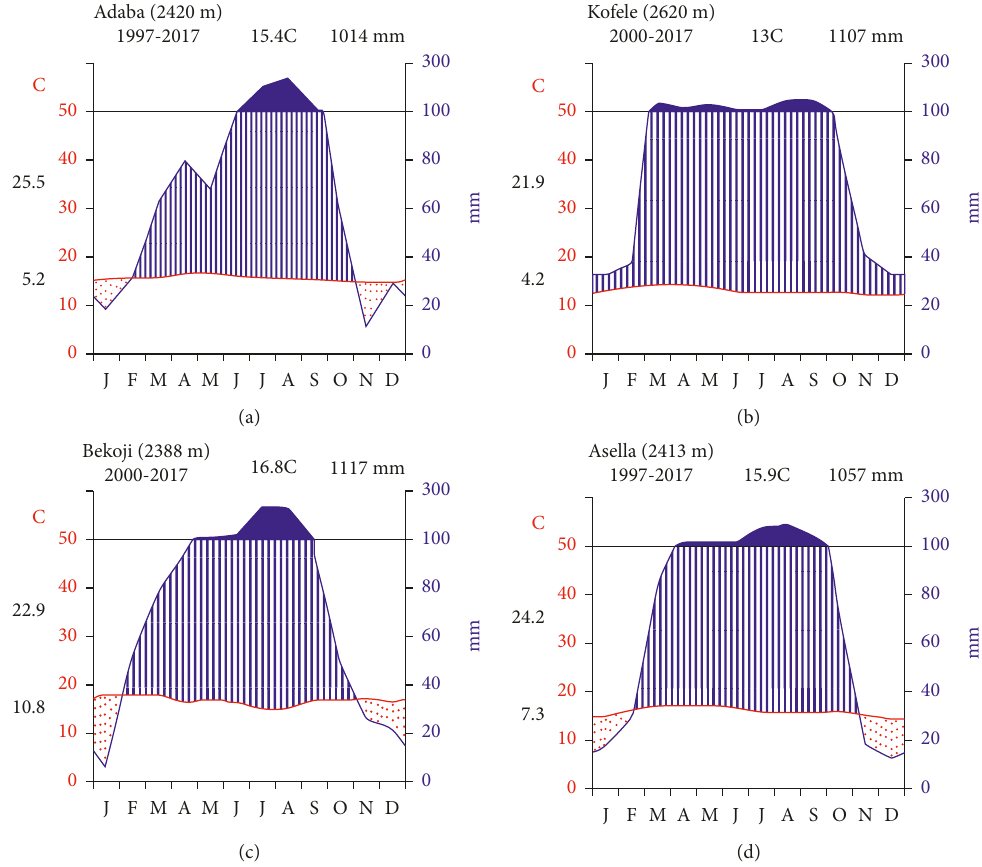
Figure 2: Climatic diagram of meteorological stations of the research sites (source: National Meteorological Service Agency